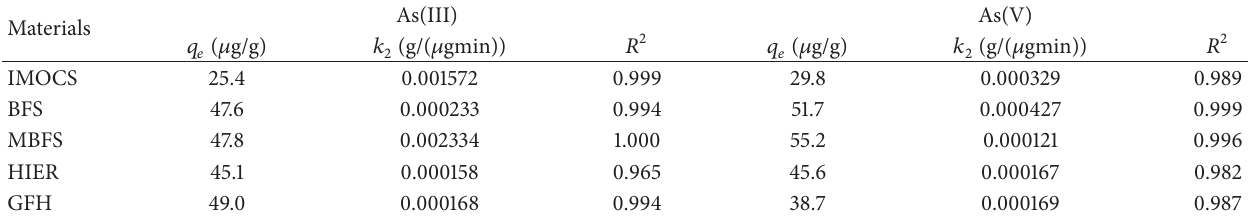
Table 2: Pseudo-second-order kinetic model parameters for As(III) and As(V) sorption on industrial by-products. Materials